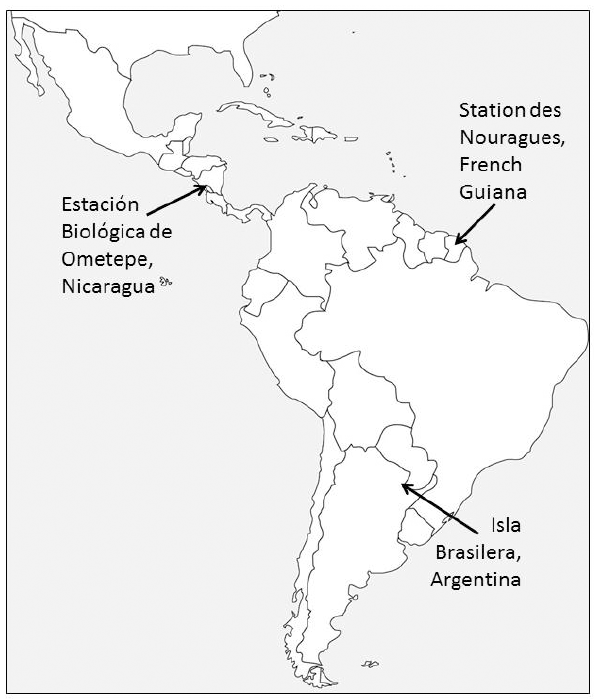
Figure 1. Distribution of the field sites in Nicaragua, French Guiana, and